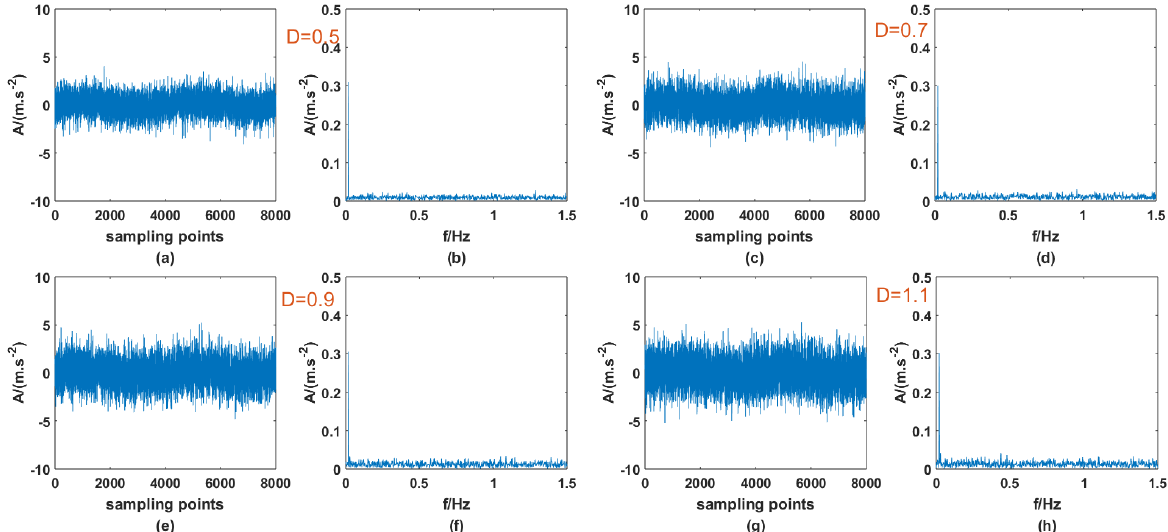
Figure 12. Input signal with AWGN of different D ( a ) time domain ( D = 0.5), ( b ) frequency domain ( D = 0.5), ( c ) time domain ( D = 0.7), ( d ) frequency domain ( D = 0.7), ( e ) time domain ( D = 0.9), ( f ) frequency domain ( D = 0.9), ( g ) time domain ( D = 1.1), ( h ) frequency domain ( D = 1.1).